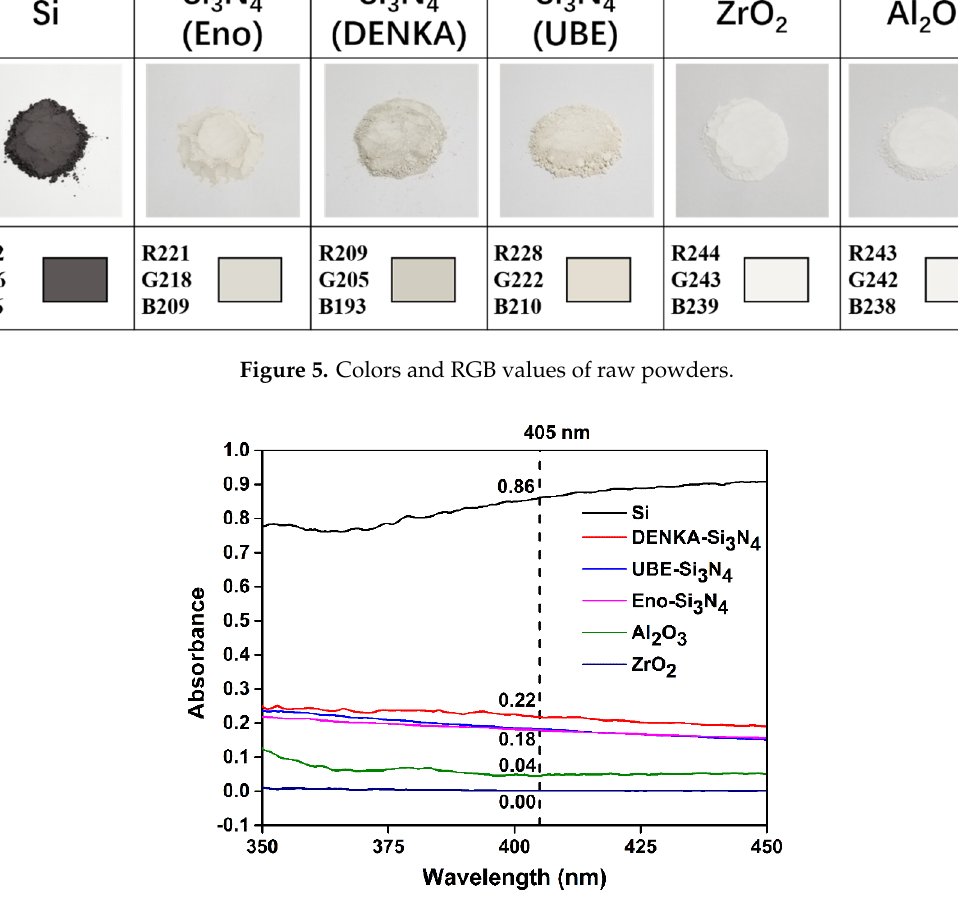
Figure 6. The absorbance of raw powders.